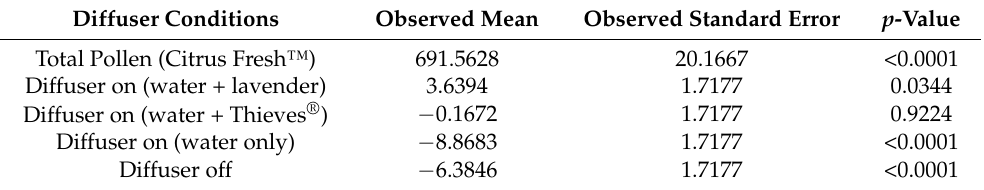
Table 3. Mean and standard error for each set of experimental conditions run on lodgepole pine pollen. The values for the different experimental conditions represent the averaged values of the additional or decreased amounts of pollen relative to the count for Total Pollen Citrus Fresh™.